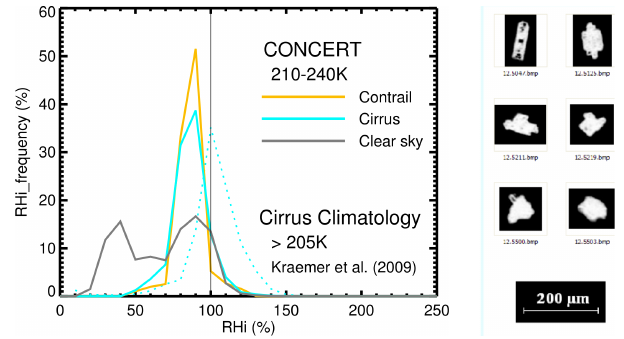
Fig. 2. Left panel: Frequency of occurrence of RH ice in contrails, cirrus and clear sky during CONCERT (solid lines) and for a broad range of cirrus conditions (dotted line, from Kr¨amer et al., 2009, 5.6 h observation time, 28 flights). CONCERT sampling times: clear sky 0.9 h, cirrus 2.3 h, contrails 1.7 h, Flight dates: Oct. 29. (1 flight), Nov. 17 (2 flights), Nov. 19 (2 flights), Nov. 20 (1 flight). Right panel: large ice crystals observed inside of the cirrus and contrails during CONCERT.